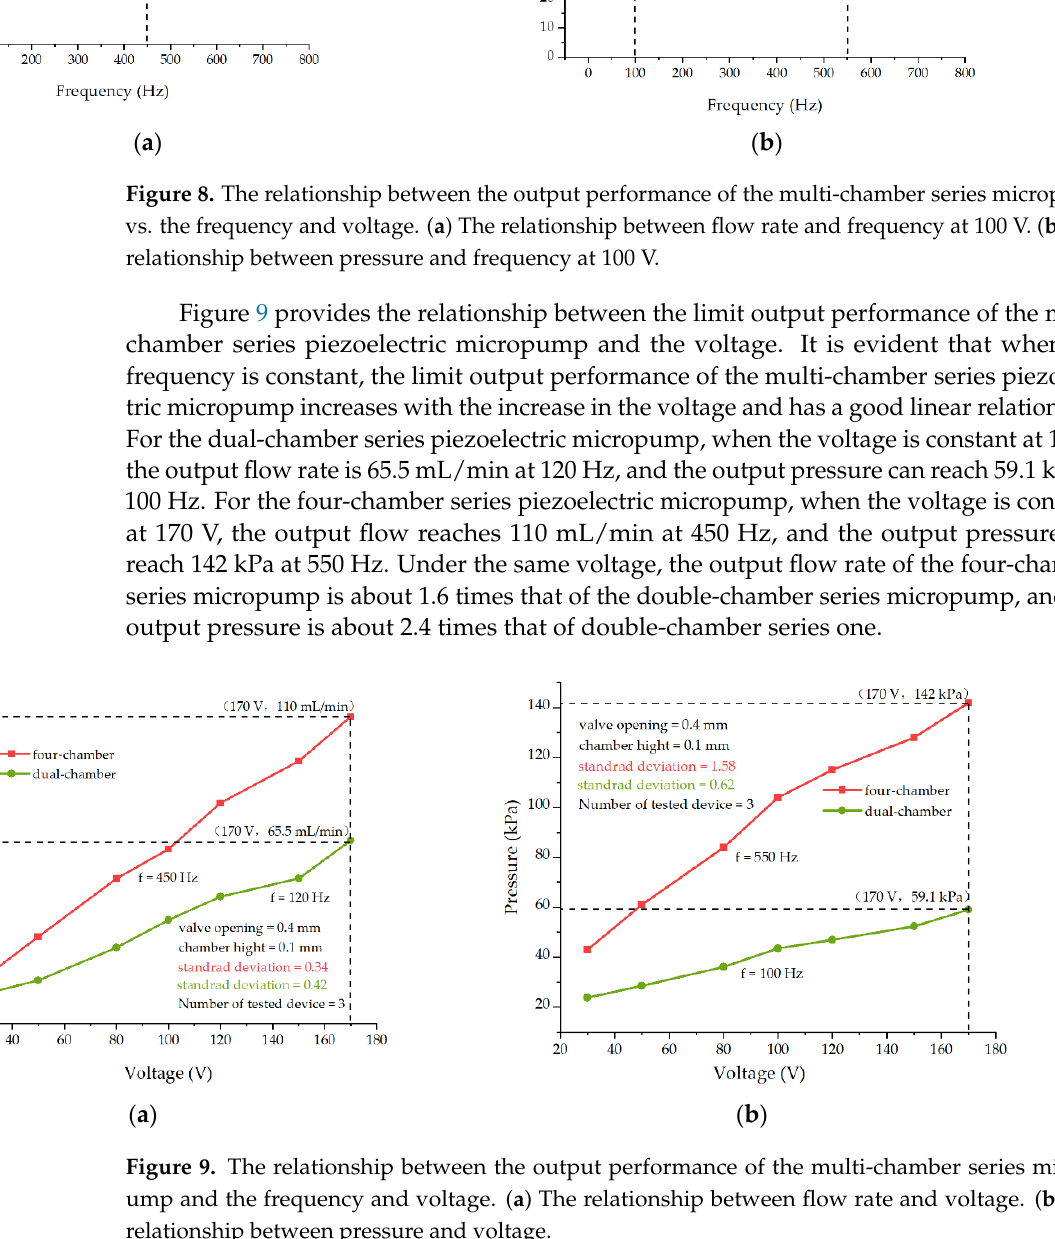
Figure 9. The relationship between the output performance of the multi-chamber series micro- pump and the frequency and voltage. ( a ) The relationship between flow rate and voltage. ( b ) The relationship between pressure and voltage.